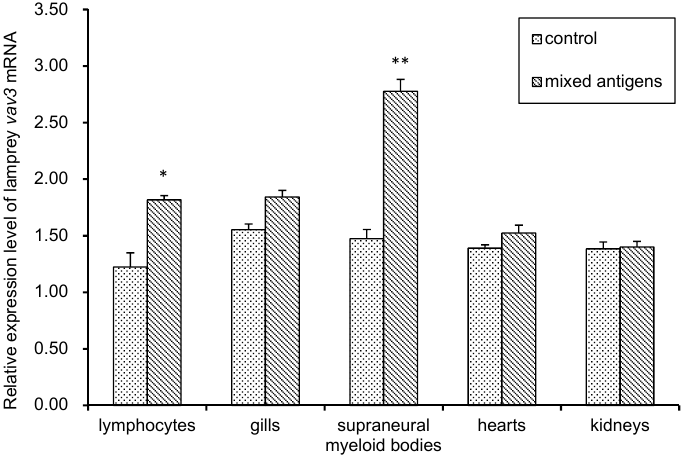
Figure 4. The relative expression levels of the lamprey vav3 mRNA in immune-related tissues before and after challenged by mixed-antigens. The lamprey vav3 mRNA levels were determined in immune-related tissues by using real-time quantitative PCR (Q-PCR) with an internal control, lamprey gapdh . The stimulated group was challenged with the mixed pathogens. The significant differences in lamprey vav3 mRNA expression between the stimulated and the corresponding control groups are indicated with asterisks, *: p < 0.05, **: p < 0.01.